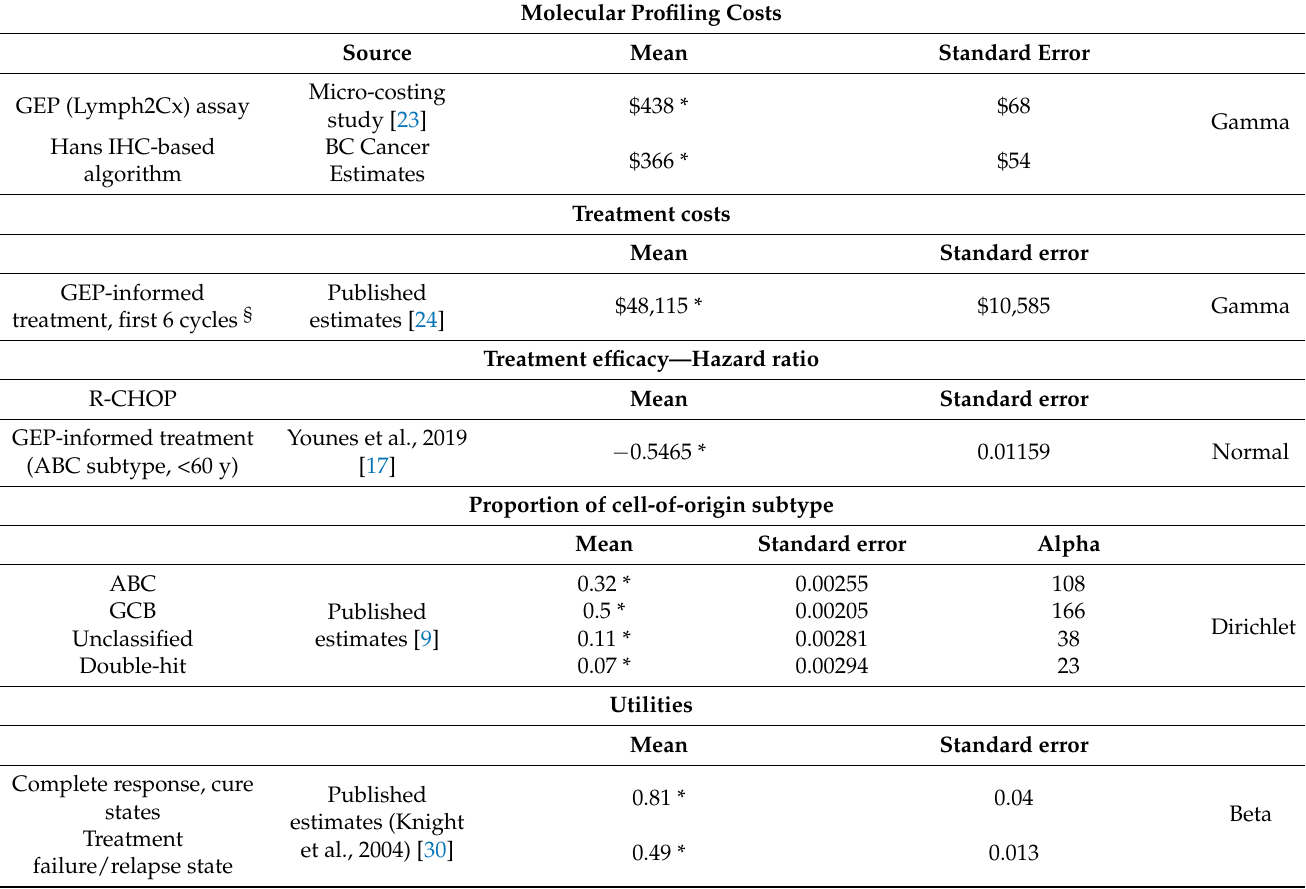
Table 2. Model parameter inputs and data sources for